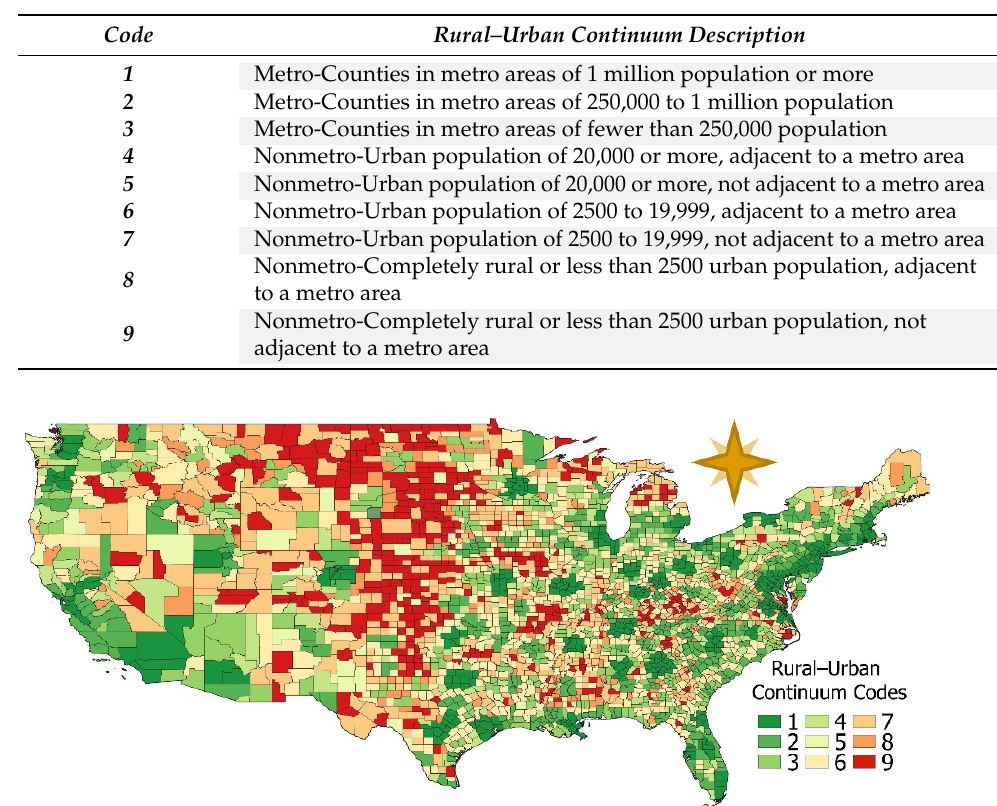
Table 1. Description of the nine US county classes from the Rural–Urban Continuum Codes.